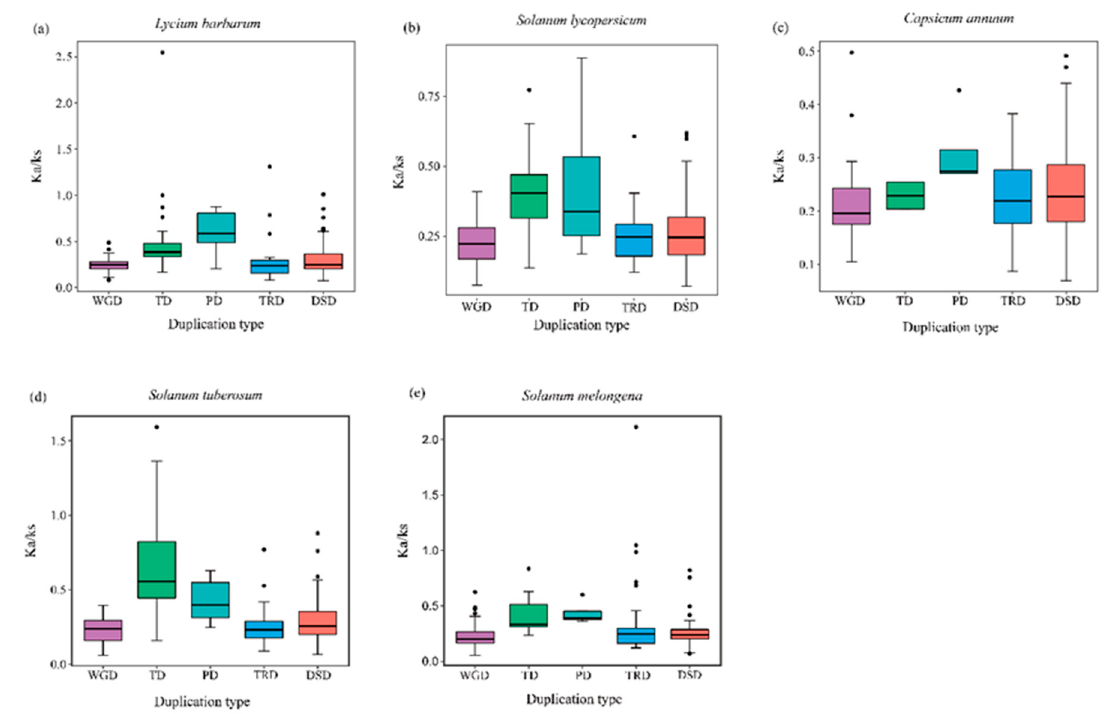
Figure 6. Ka/Ks ratios of five Solanaceae species. The x-axis represents five different duplication types. WGD: whole-genome duplicates; TD: tandem duplicates; PD: proximal duplicates; TRD: transposed duplicates; DSD: dispersed duplicates. The y-axis indicates the Ka/Ks ratio. ( a ) Wolfberry; ( b ) tomato; ( c ) pepper; ( d ) potato; ( e ) eggplant.